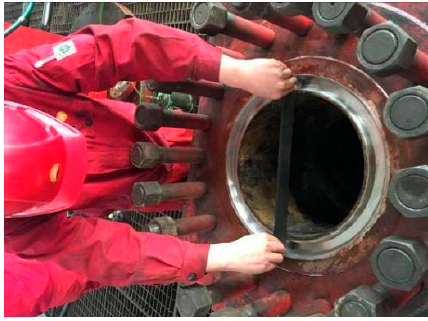
Figure 4. Eccentric wear measurement of the metal sealing ring.